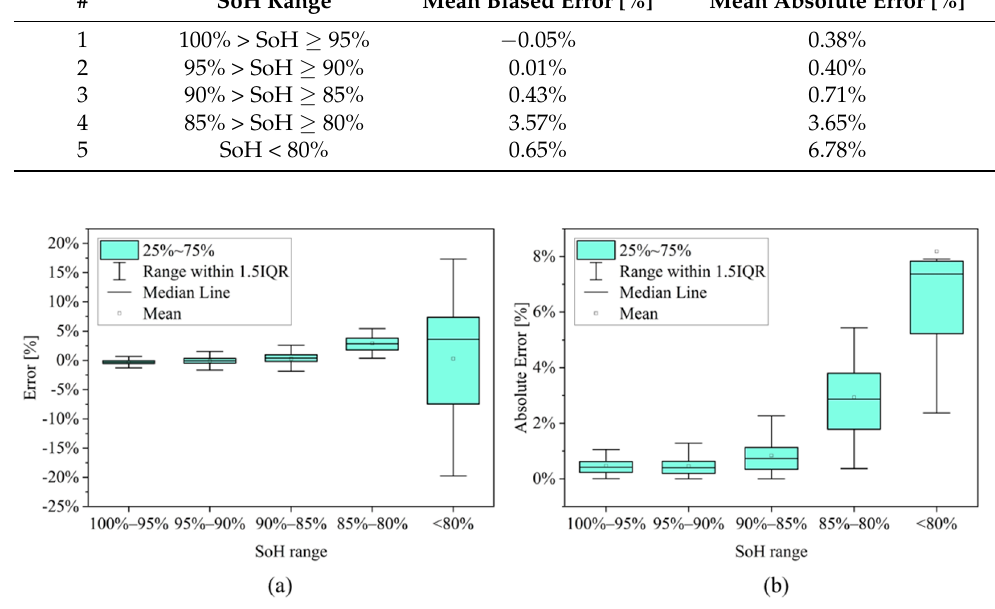
Figure 11. Box plot representation of the ( a ) error; and ( b ) the absolute error for the different SoH ranges introduced in Table 5 with 5 cells in the training